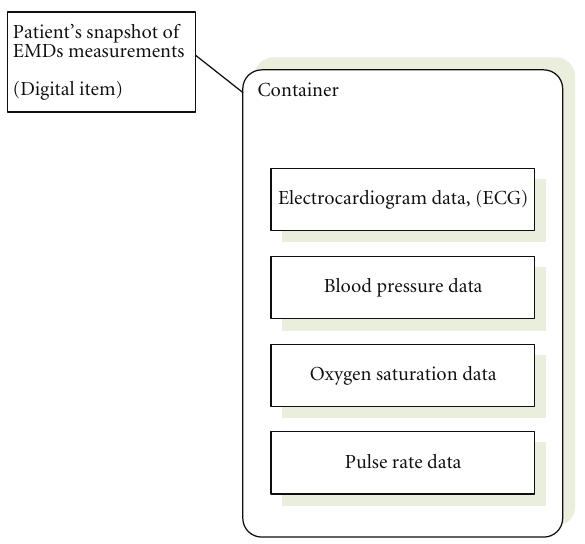
Figure 6: Abstract view of MPEG-21 digital item that presents a snapshot of EMDs measurements for a specific